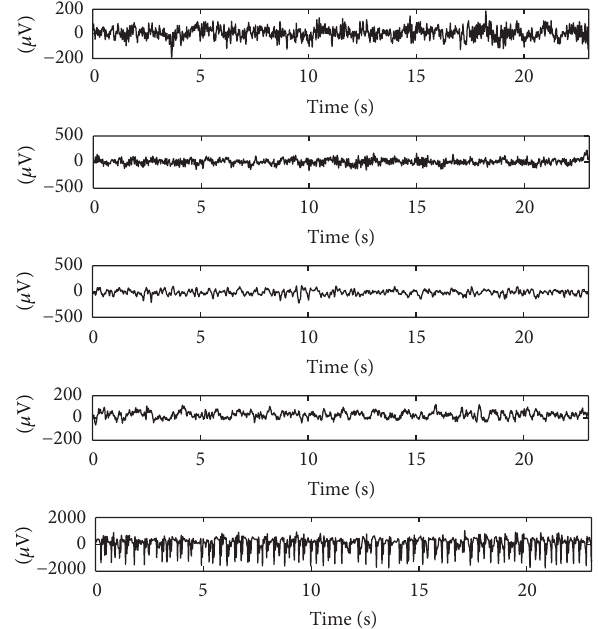
Figure 1: Examples of EEG segments from each of five sets (A, B, C, D, and E). From top to bottom: segment from A to segment from